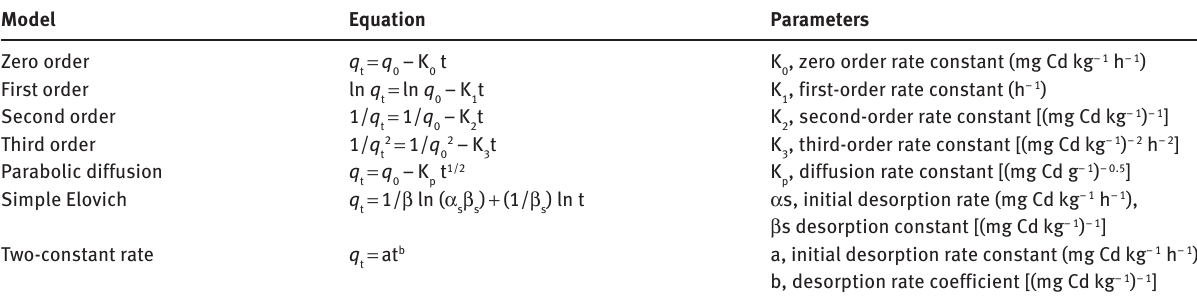
Table 5: Kinetic equations fitted to describe Cd sorption.